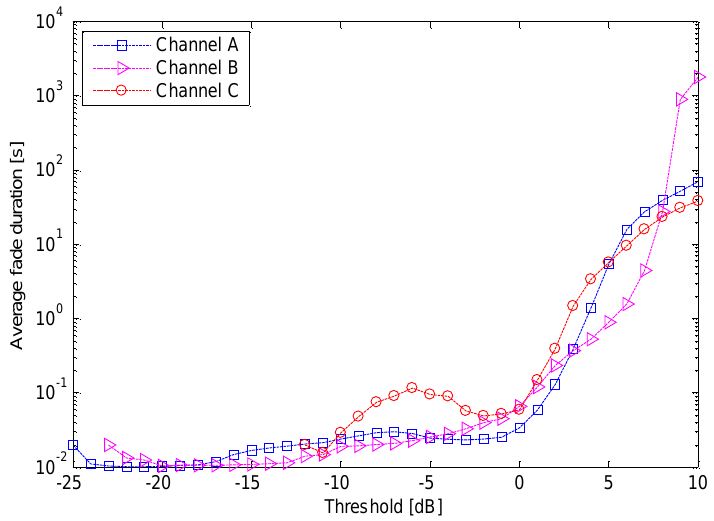
Figure 6. AFDs for the different channels.